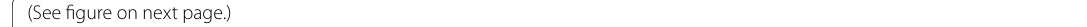
lesion(See figure on next Fig. 2 A 45-year-old female, complaining of left breast pain. (A) Craniocaudal mammographic view of both breasts, and (B) Mediolateral mammographic views of both breasts in 2020 revealed no abnormality. (C) Craniocaudal mammographic view of both breasts, and (D) Mediolateral mammographic views of both breasts in 2021 revealed left axillary tail focal asymmetry (arrows). (E) Craniocaudal mammographic view of both breasts, and (F) Mediolateral mammographic views of both breasts in 2022 revealed increased size of the left axillary tail focal asymmetry (developing asymmetry) (arrows). (G) Ultrasound image showing left axillary tail irregular hypoechoic soft tissue mass with posterior attenuation, and vertical orientation and color flow on color Doppler examination. (H) Craniocaudal CEM view of both breasts, and (I) Mediolateral CEM views of both breasts revealed left axillary tail mass lesion with homogenous enhancement (arrows). Pathology revealed invasive lobular carcinoma. CEM confirmed the malignant nature of left breast